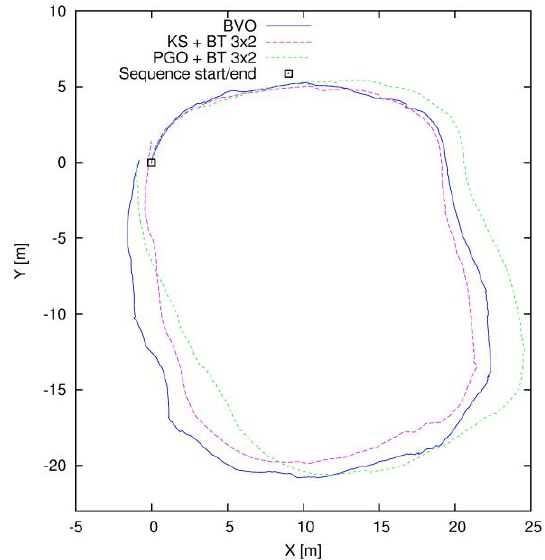
Figure 5. Selected result trajectories for own